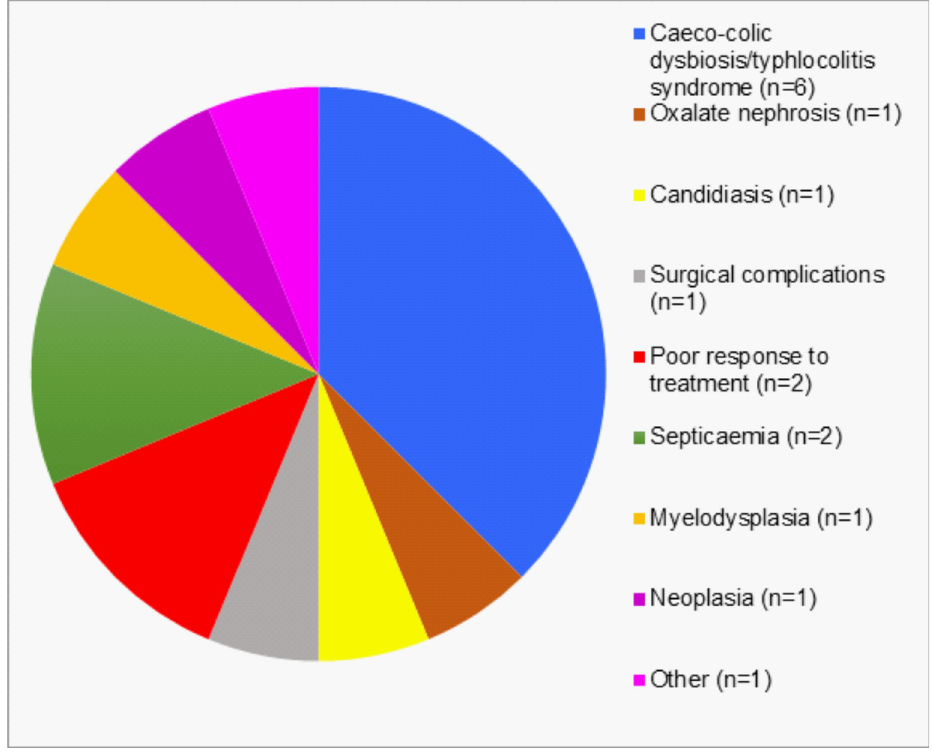
Fig 1. Reasons for negative short-term outcomes for koalas resulting in euthanasia during treatment of chlamydial disease or Chlamydia antigen test positivity only in the koala management program.